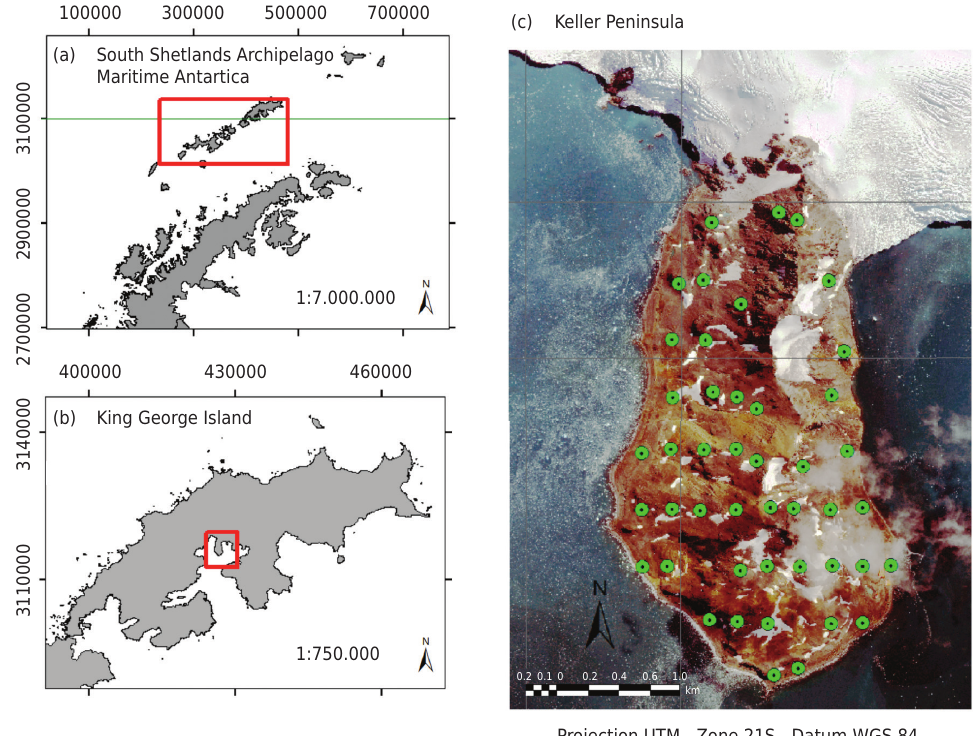
Figure 1. Localization of the study area (a, b) and the collection points in the soil grid in Keller Peninsula